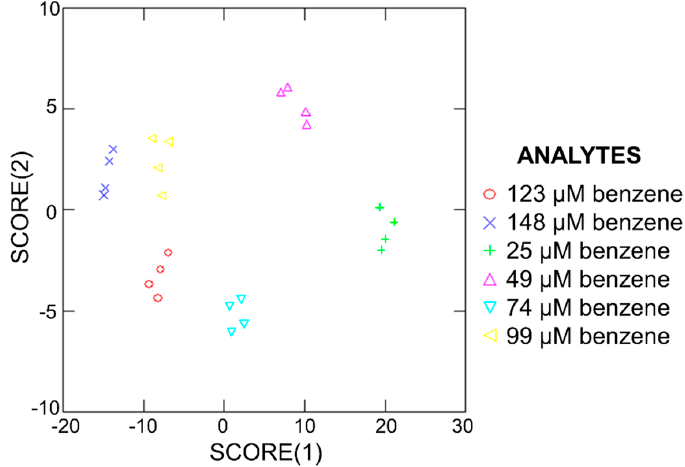
Figure 12. Array-based detection of various concentrations of analyte 1 with fluorophore 9 in Providence snow, with cyclodextrins as predictors.